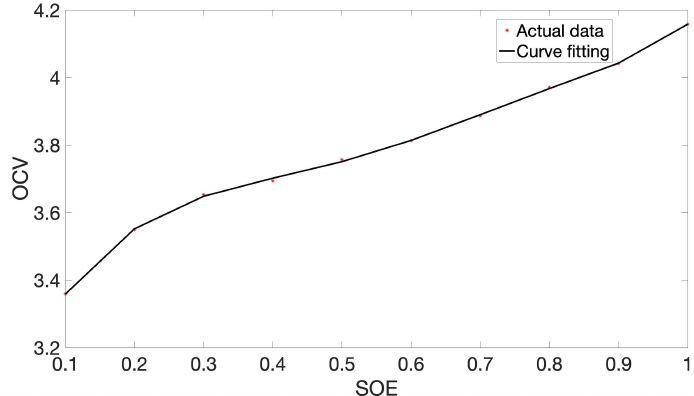
Figure 5. OCV-SOE curve.